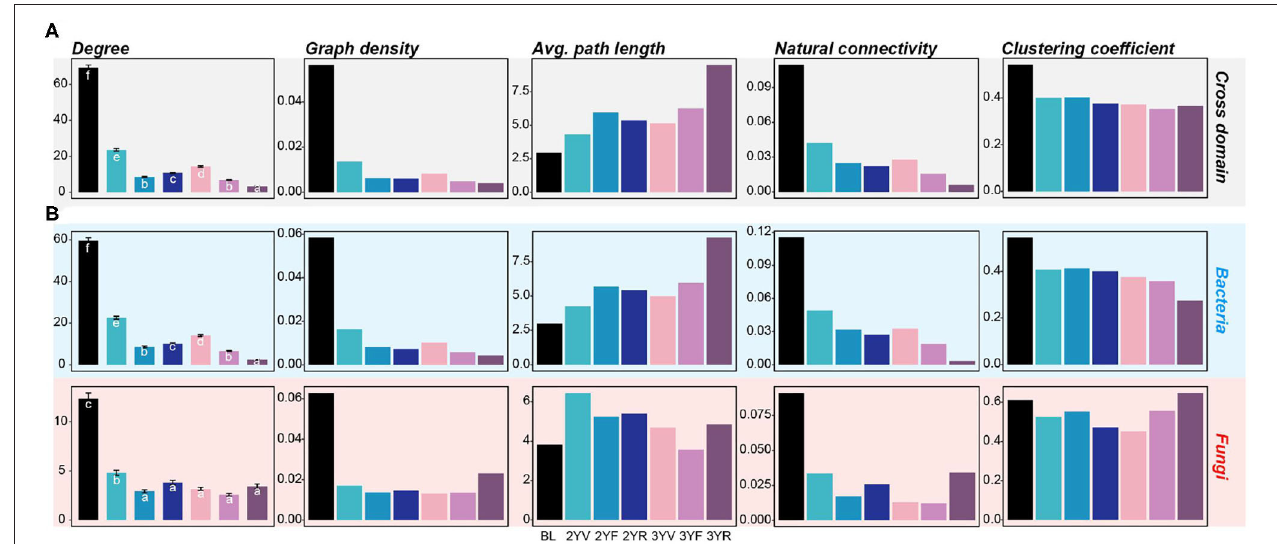
FIGURE 4 | Network-level topological properties of cross-domain and single-domain networks are constructed from each developmental stage. (A) Network-level topologies of cross-domain networks. (B) Network-level topologies of bacterial and fungal subnetworks. The colors of the bars represent different developmental stages. Different letters denote significance between the compared groups ( P <